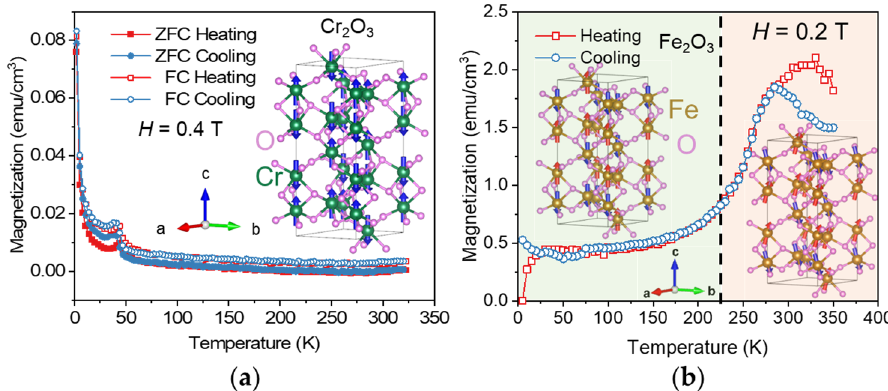
Figure 6. Magnetization of ( a ) Cr 2 O 3 , ( b ) α -Fe 2 O 3 epitaxial films along the a-axis as a function of temperature. A magnetic field of 2 T is applied perpendicular to the A-plane during the field-cooling for the Cr 2 O 3 film. The inset of ( a ) shows the unit cell of Cr 2 O 3 with the spin orientations for the Cr 3+ ions. The insets of ( b ) show the unit cells of α -Fe 2 O 3 with the spin orientations for the Fe 3+ ions before and after the Morin transition.